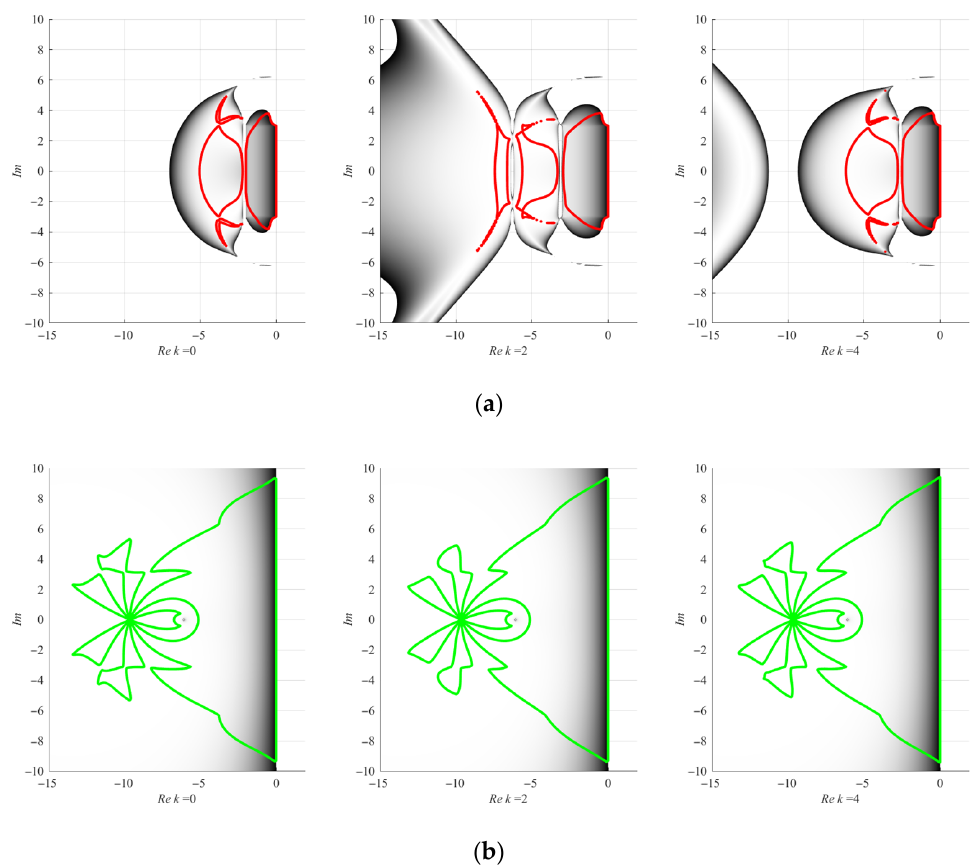
Figure 5. Stability and preference regions of XA4 composition scheme using semi-implicit CD ( a ) and implicit midpoint ( b ) solver as basic methods for different eccentricity 𝑘 of the problem’s matrix. Stability and preference regions of the semi-implicit method change for various 𝑘 . All figures in panel ( b ) are almost similar.